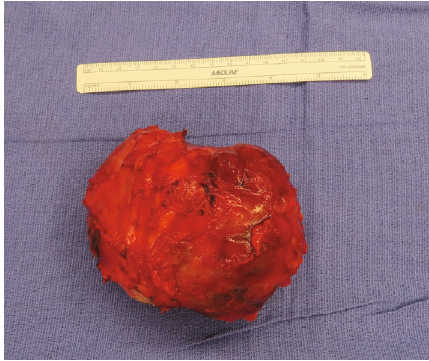
Figure 2: Intraoperative image of excised tumor measuring